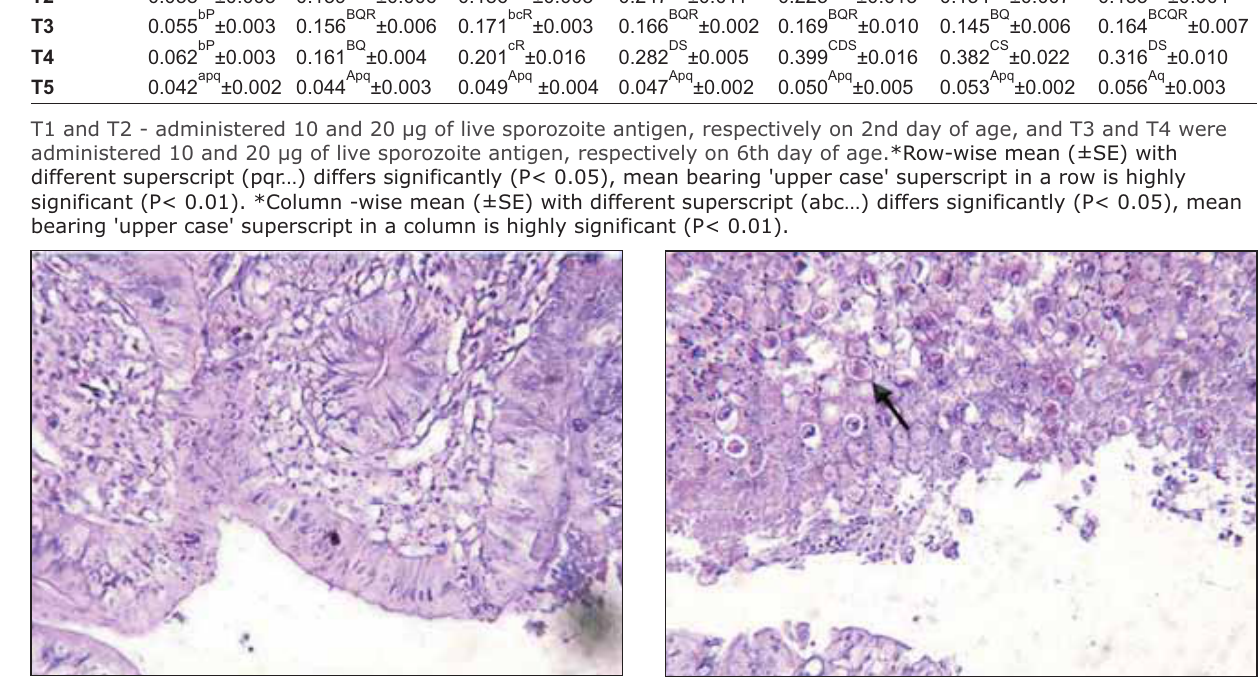
Figure-2: Group T4 showing stunting of villi in the caeca (H & E x400).